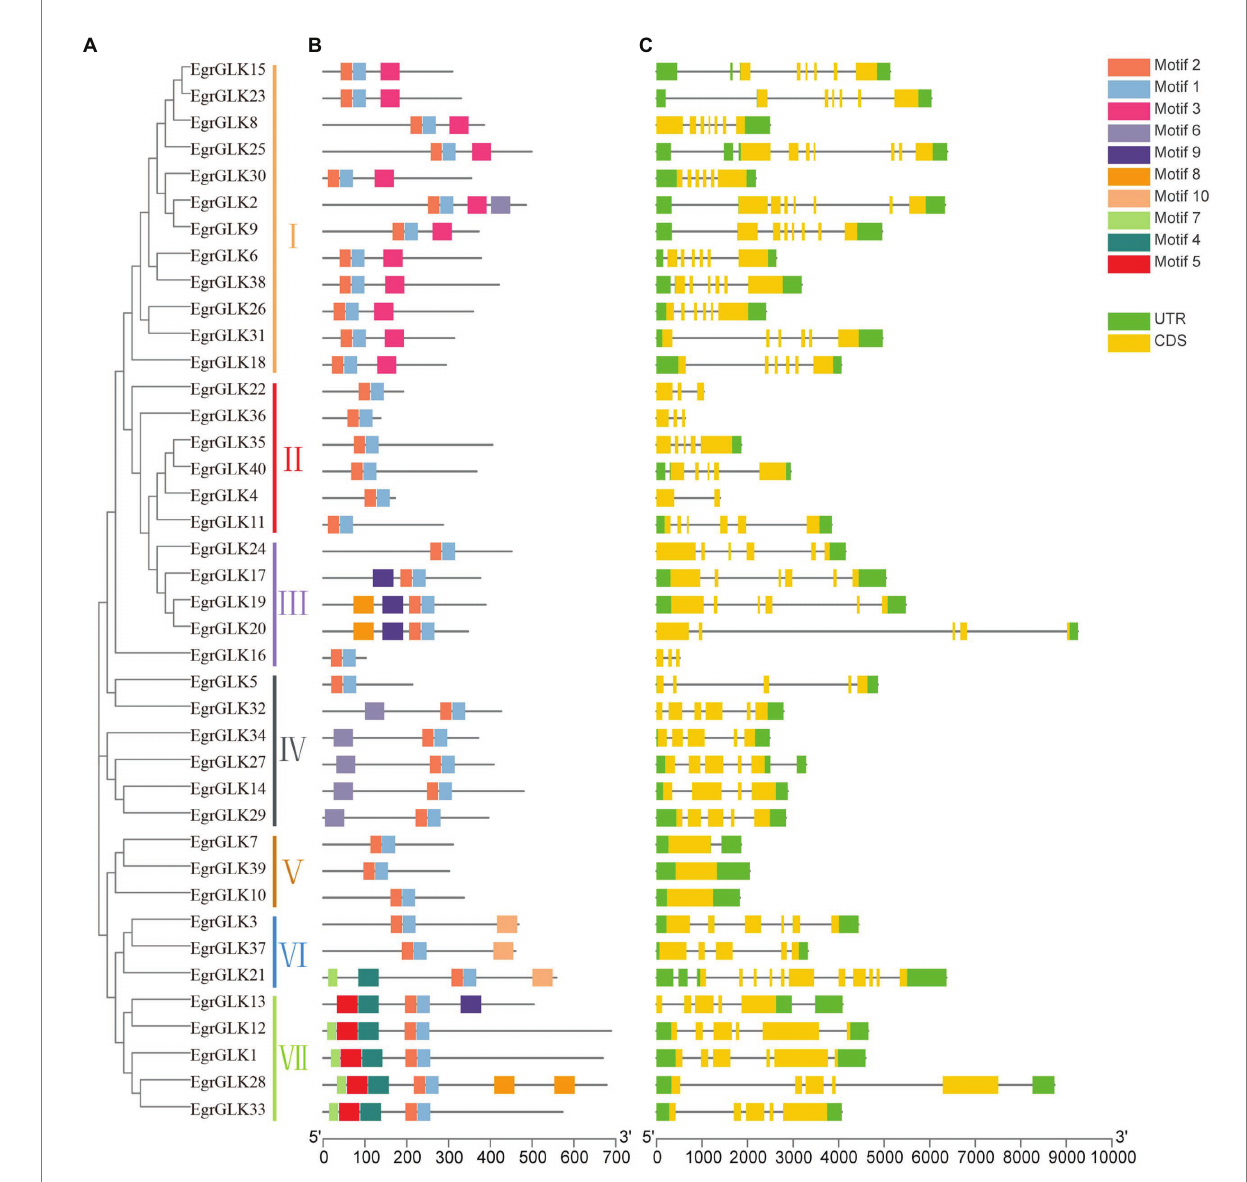
FIGURE 4 Phylogenetic tree, conserved motifs, and gene structure of EgrGLK genes of E. grandis . (A) Phylogenetic reconstruction for EgrGLK proteins. (B) Ten conserved motifs indicated by different colors. (C) Gene structure with exons and introns